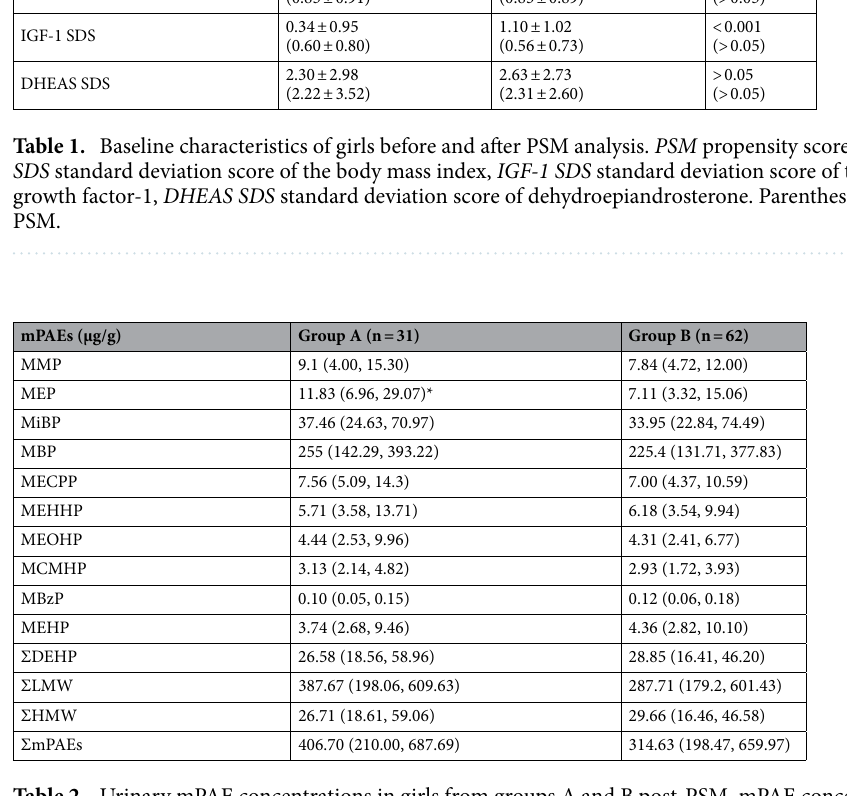
Table 2. Urinary mPAE concentrations in girls from groups A and B post-PSM. mPAE concentrations are described as a median (quartile). ΣDEHP: sum of creatinine-corrected concentrations of MCMHP, MEHP, MEOHP, MEHHP, and MECPP. ΣLMW: sum of creatinine-corrected concentrations of MBP, MMP, MiBP, and MEP. ΣHMW: sum of creatinine-corrected concentrations of ΣDEHP and MBzP. ΣmPAEs: sum of creatinine- corrected concentrations of all mPAEs. *The concentration of urinary MEP in group A was significantly higher than that in group B ( P <